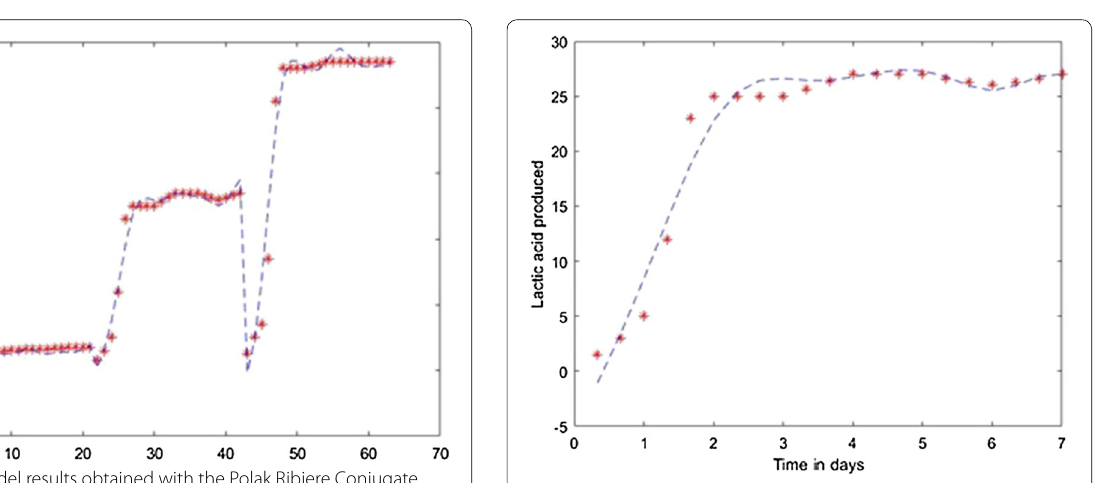
Fig. 14 Simulation of the model on 40% glycerol 60% LGJ for Scaled Conjugate Gradient